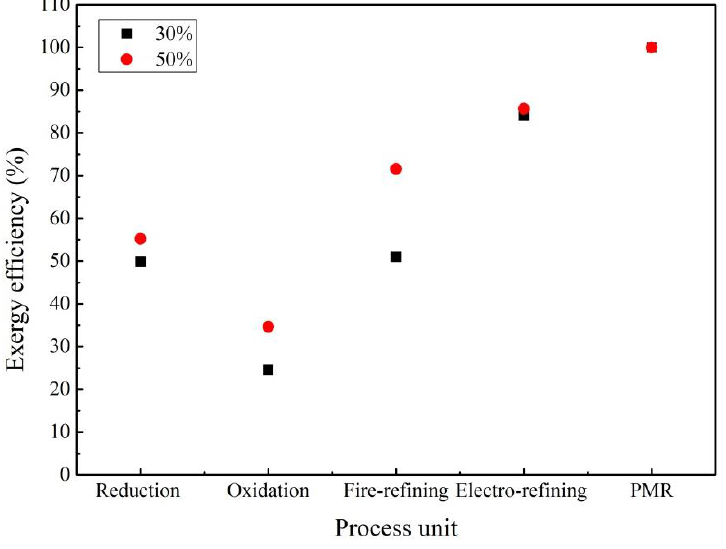
Figure 10. Exergy efficiency for different percentage of e-waste in the feed material.